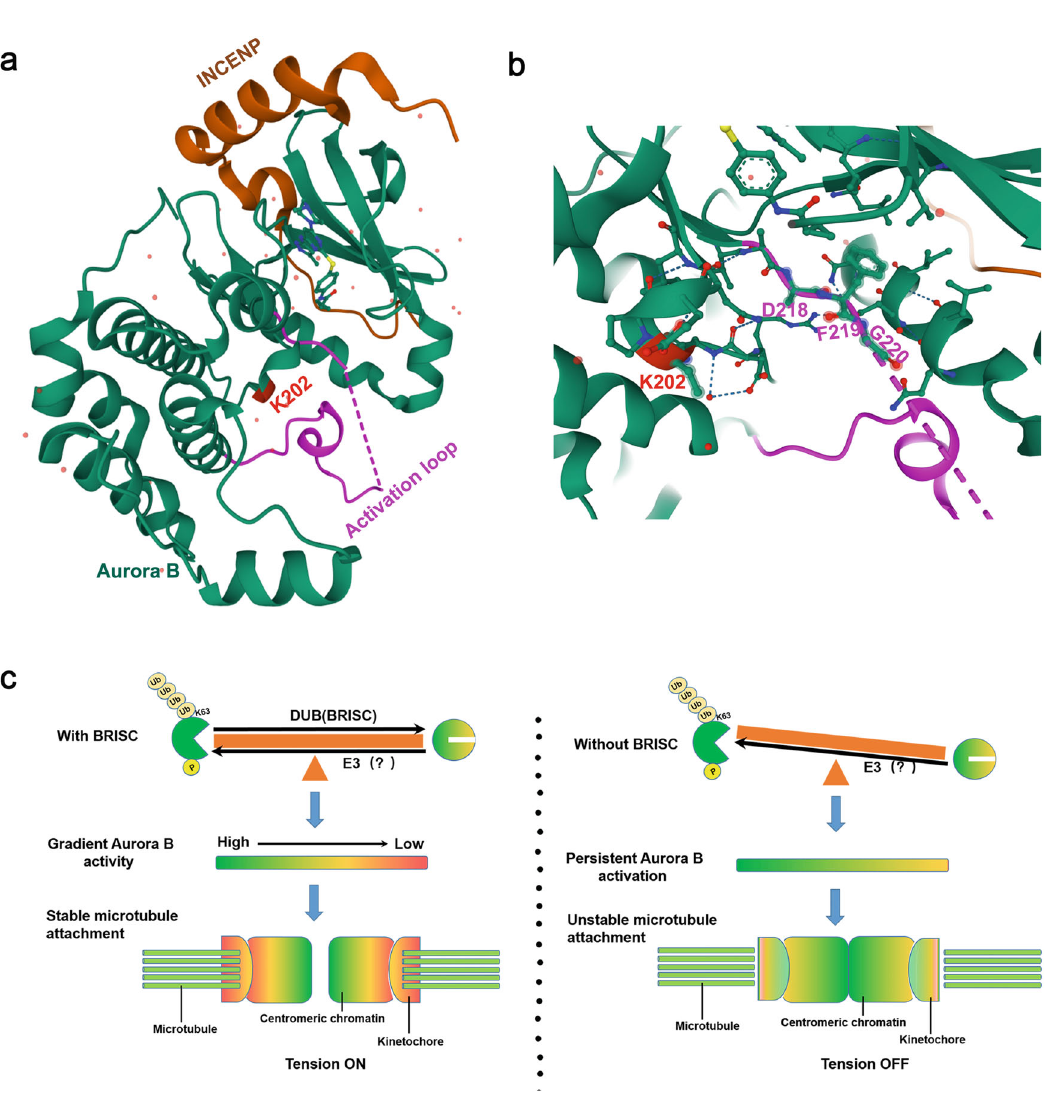
Fig. 8 A working model explaining the mechanism by which Aurora B activation and kinase activity are regulated by K63-lined ubiquitination. a The crystal structure of human Aurora B kinase in complex with INCENP and VX-680 (PDB ID: 4AF3) 58 . K202 (red) is located in the activation loop (purple) of Aurora B (green). b Magni fi ed view showing the position of K202 and surrounding DFG (Asp-Phe-Gly) motif at the start of the activation loop. The crystal structure of human Aurora B Kinase provides us with strong support. We propose that ubiquitination at K202 might be critical for the autoactivation of Aurora B, which in turn facilitates the phosphorylation of TSS in INCENP, required for CPC complex formation and full activation of Aurora B. c Schematic showing BRISC-regulated K63-Ubs of Aurora B is important for creating a dynamic gradient Aurora B kinase activity to ensure correct KT-MT attachment and chromosome segregation. sgAbro1 (designed on https://chopchop.cbu.uib.no) were subcloned into the lenti- pcDNA3.1-V5-His-B, pEGFP-C2 (CMV promoter; Takara Bio Inc.), pcDNA3.1-Flag- CRISPRv2 vector using the following oligonucleotides: sgBRCC36-1-Forward-5 ′ - HA (CMV promoter) or pGEX-6P-2 plasmid (tac promoter; GE Healthcare) to gen- erate pcDNA3.1-V5-His-Aurora B, pEGFP-Aurora B, pcDNA3.1-HA-Aurora B, and pGEX-6P-2-Aurora B. Aurora B mutants were generated using site-directed muta- genesis. For generation of stable HeLa BRCC36 or Abro1 knock out cells, sgBRCC36/